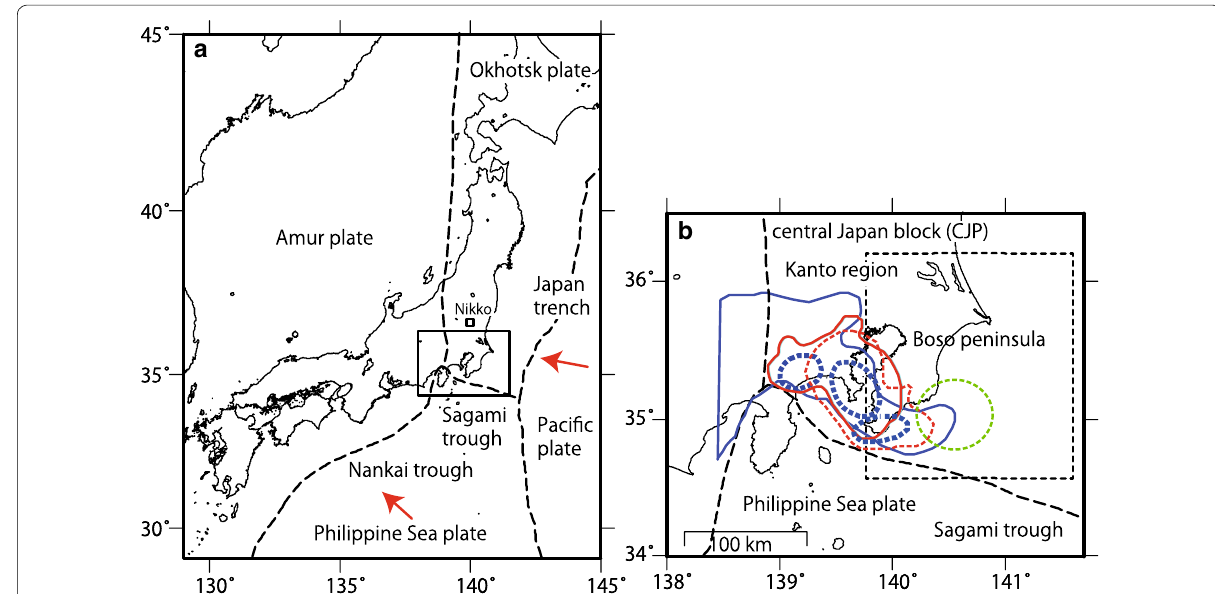
Fig. 1 a Tectonic setting in and around Japan. Broken lines indicate plate boundaries. Four major plates are converging in Japan. b Enlarged map of the Boso peninsula indicated by the rectangle in a . Broken lines indicate plate boundaries. The broken red line indicates the source area of the 1703 Genroku earthquake (Sato et al. 2016), while the solid red line indicates the source area of the 1923 Taisho Kanto earthquake (Matsu’ura et al. 2007). The blue line indicates the coupled area estimated by Noda et al. (2013) on the basis of GNSS data. The blue broken lines indicate the three asperities assumed by Sato et al. (2016). The black broken rectangle shows the fault patch used to estimate the aseismic slip on the plate interface between the Philippine Sea plate and the continental plate (see text). The green broken line schematically shows the Boso slow slip area, which lies in the transition zone between a locked area and an aseismic creeping area. The central Japan block is explained in the